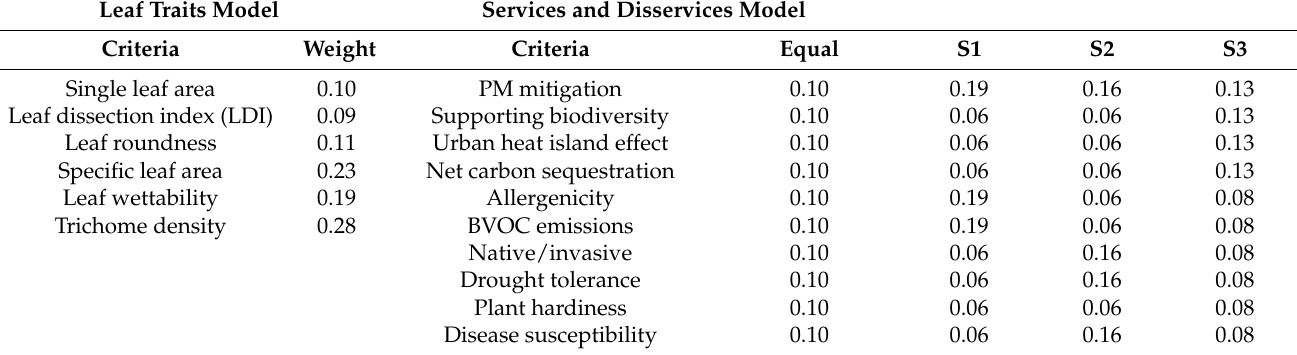
Table 2. The assignment weights for each criterion in the leaf traits and services and disservices models. Each criterion in the services and disservices model was initially assigned with equal weights (equal). A scenario analysis based on three scenarios (S) and weights within each scenario (S1, S2, and S3) assigned in accordance to the preferred